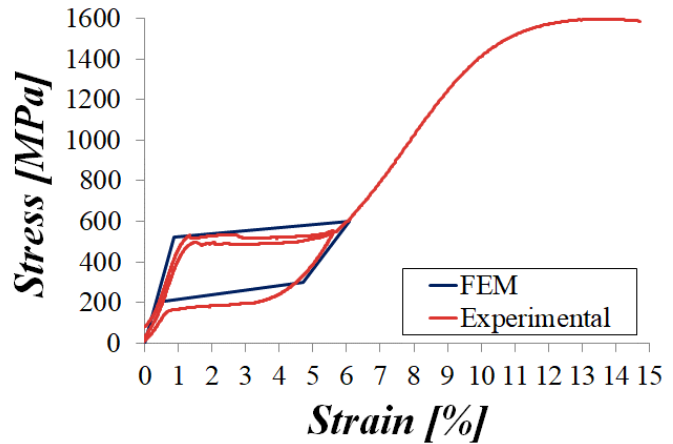
Figure 1. Experimental tests on the nickel-titanium (NiTi) alloy mechanical behavior (in red) compared to the obtained finite element (FE) behavior (in blue). The stress-strain diagram was obtained by gradually applying a load to the sample and measuring the deformation, FEM = finite element method.